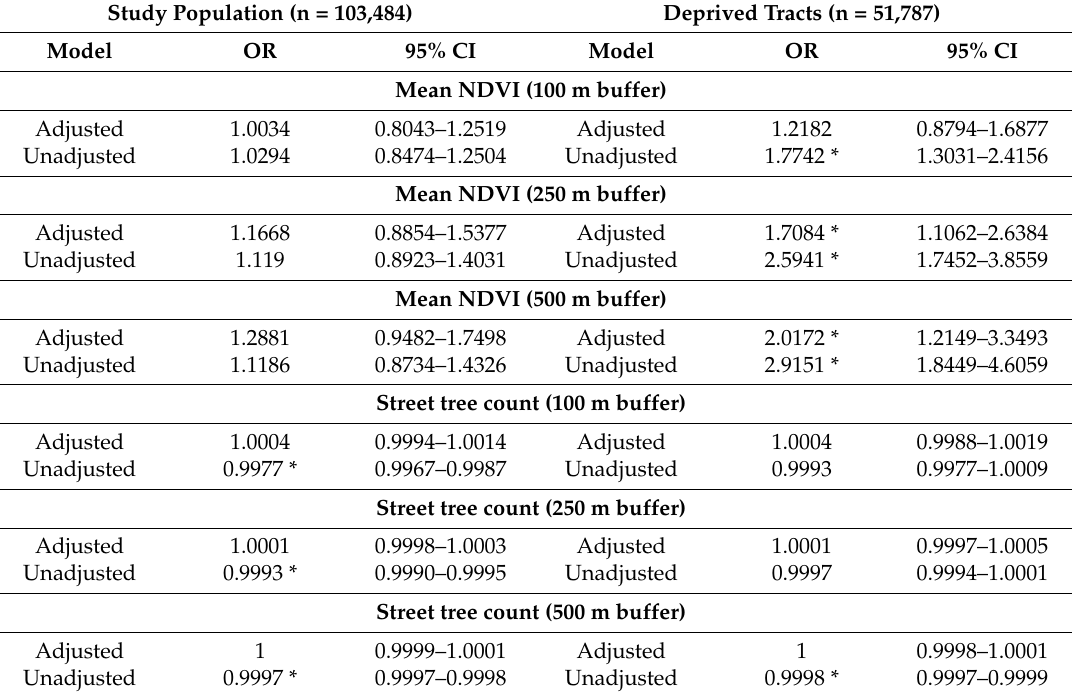
Table 7. Mixed-effects logistic regression results for small for gestational